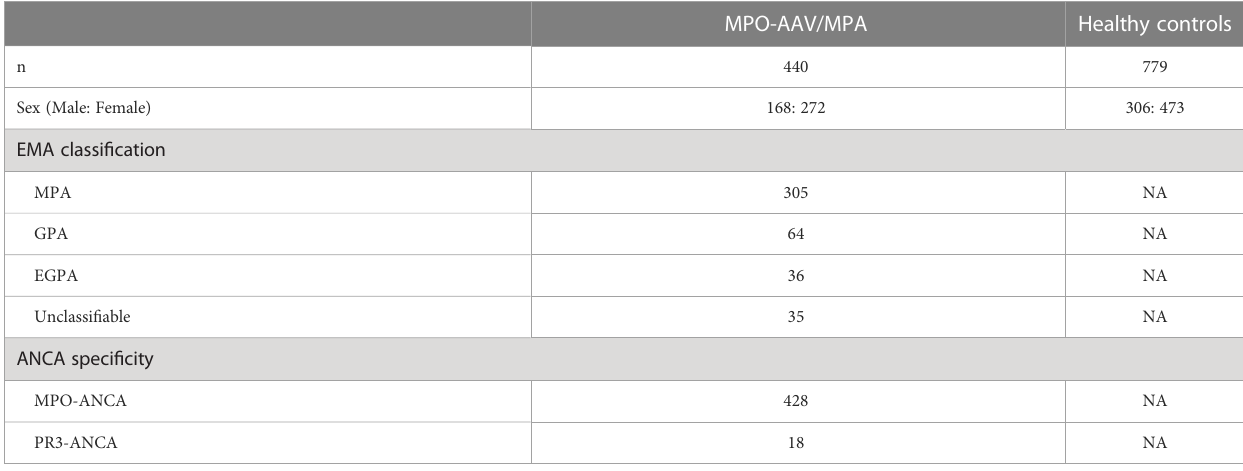
TABLE 1 Characteristics of the patients and healthy controls examined for the association of HLA-DRB1*09:01 and DQA1*03:02 with susceptibility to MPO-AAV and